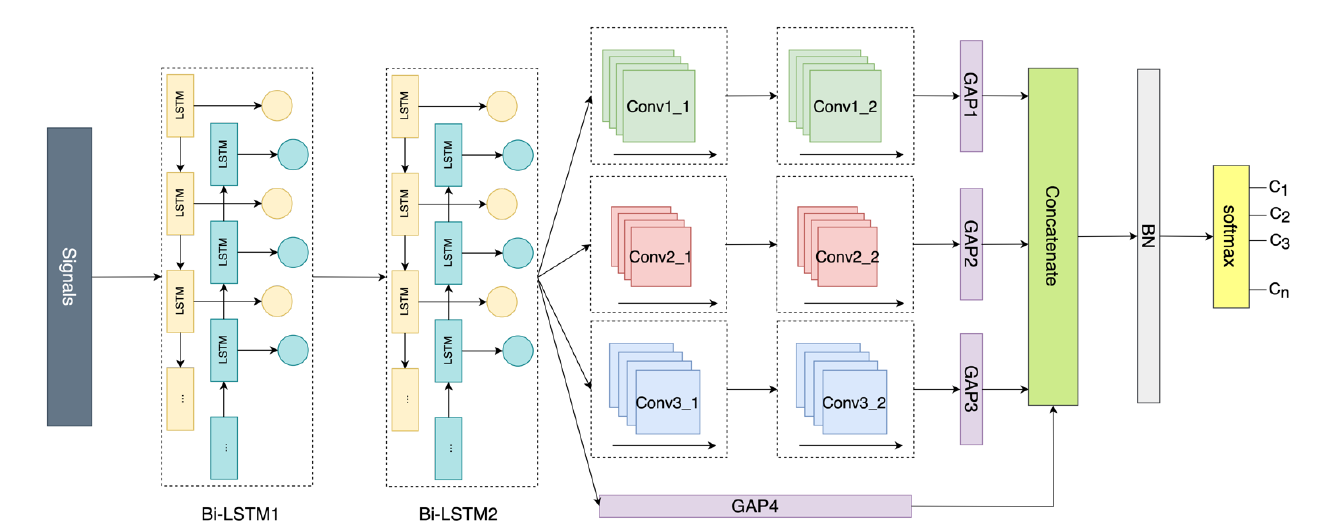
Figure 2. Architecture of the landmark identification model.